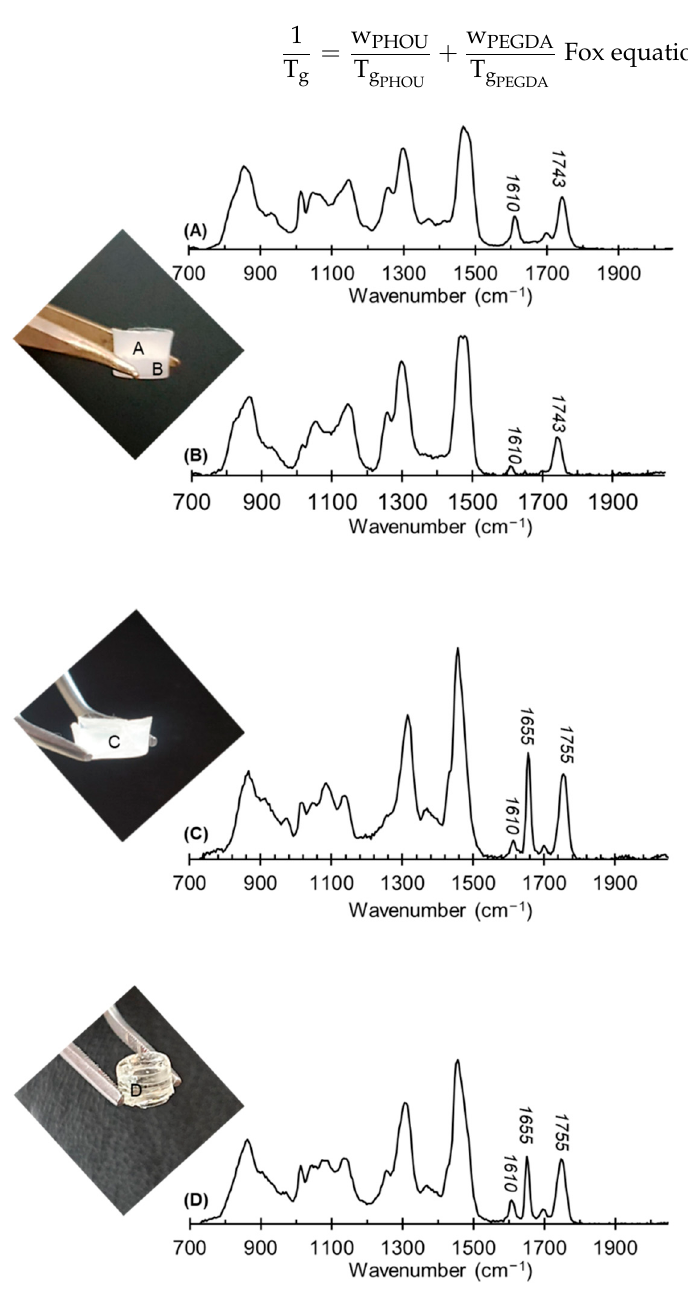
Figure 3. Raman spectra of the two zones ( A , B ) present in the PHBHHx20PEGDA80 network, PHOU 20 PEGDA 80 network ( C ) and PHOU 50 PEGDA 50 network ( D ). PHOU 20 PEGDA 80 network ( C ) and PHOU 50 PEGDA 50 network ( D